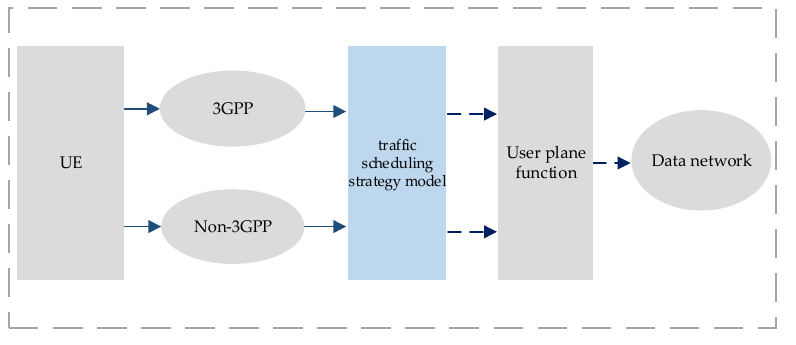
Figure 1. Architecture for ATSSS